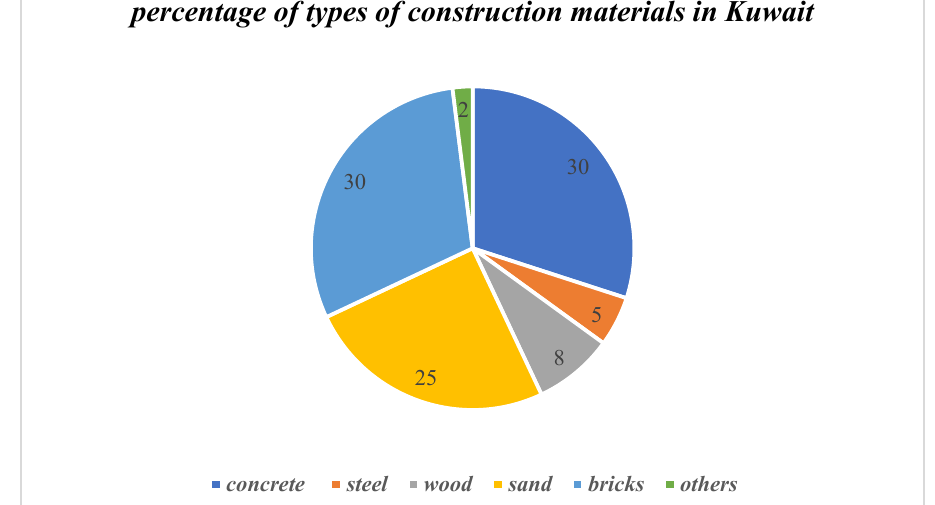
Figure 3. Different types of construction materials in Kuwait.